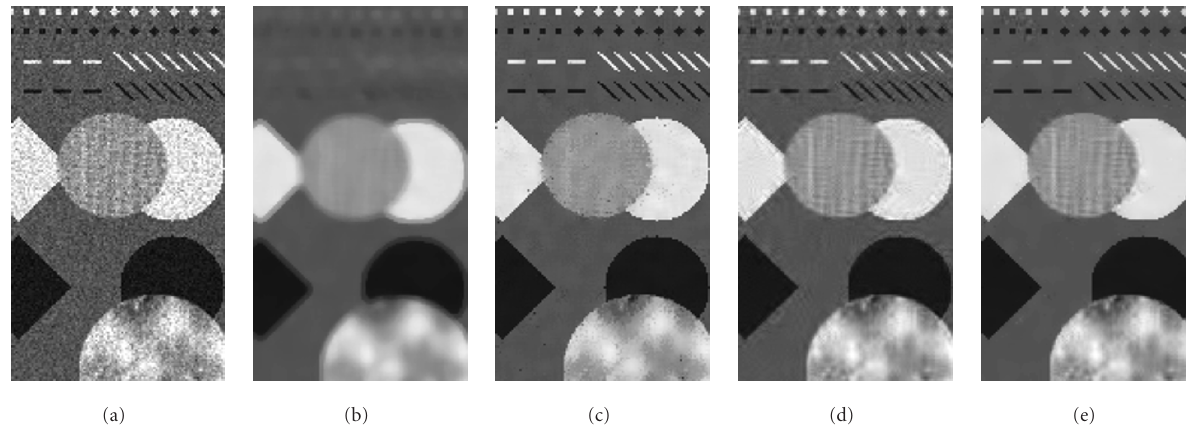
Figure 8: The visual results of processing the test image (Figure 1) fragment by component filters and their final nonlinear composition: (a) the test image fragment corrupted by multiplicative Gaussian noise with σ 2 µ = 0 . 012, (b) the output of 7 × 7 L pq filter, (c) the output of 7 × 7 MSF filter, (d) the output of 8 × 8 DCT filter, and (e) the output of the three-state hard-switching